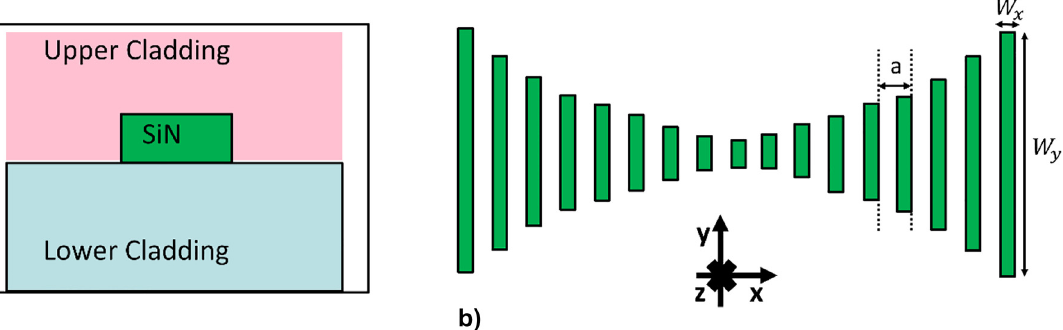
Figure 1: Schematics of the 1D PhC, showing its tapering law: (a) Cross-section of the structure, (b) quadratic tapering of the sticks of the